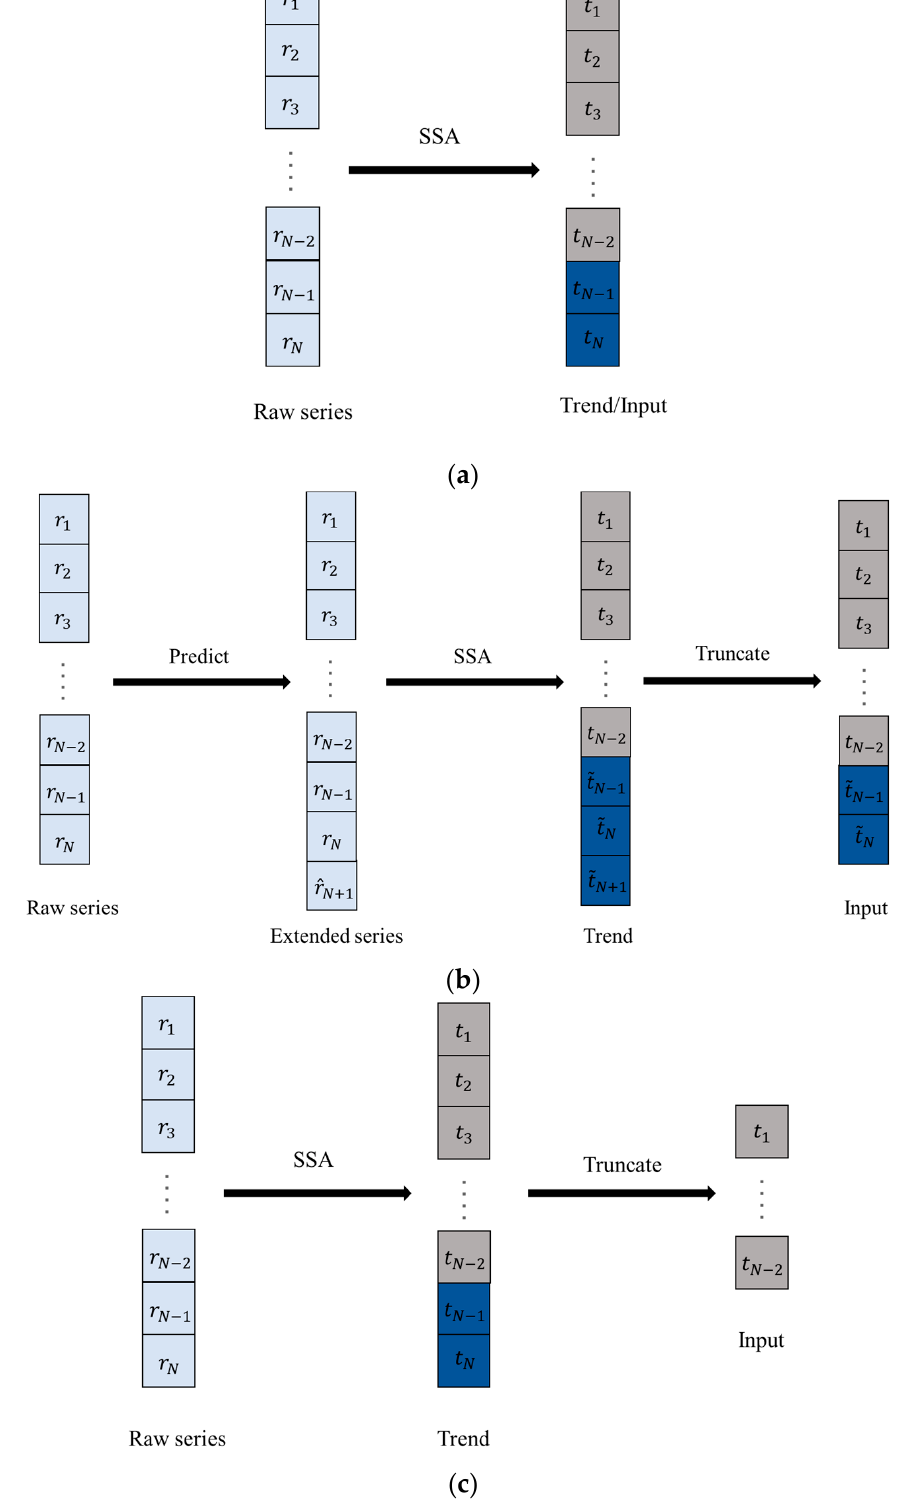
Figure 2. Diagrams of three schemes of real-time decomposition: ( a ) basic real-time decomposition; ( b ) quasi real-time decomposition; ( c ) truncated real-time decomposition.